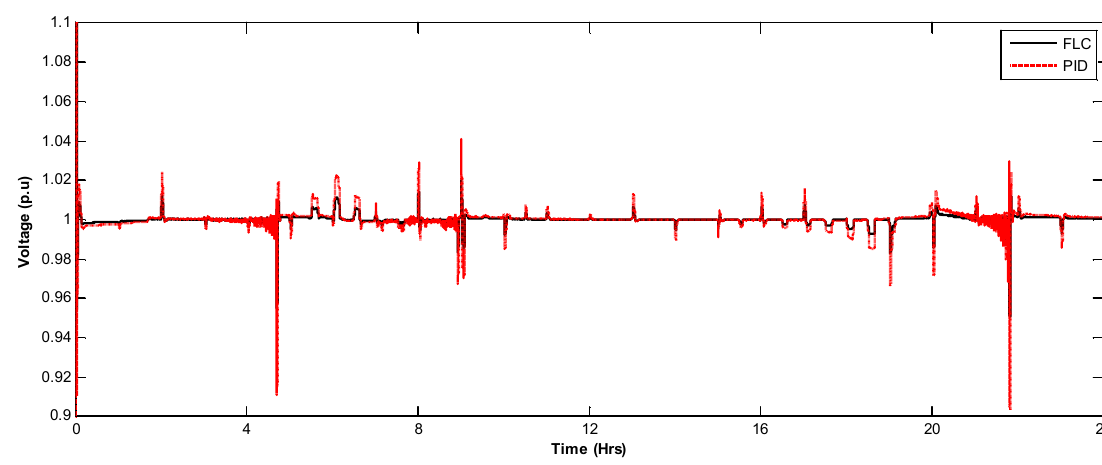
Figure 14. DC bus voltage deviation: PMS based on FLC versus PMS based on PID controllers.